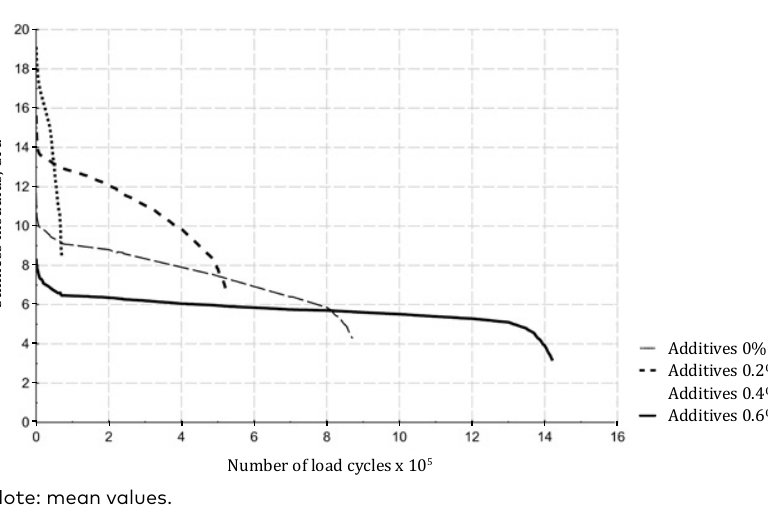
Additives 0% Additives 0.2% Additives 0.4% Additives